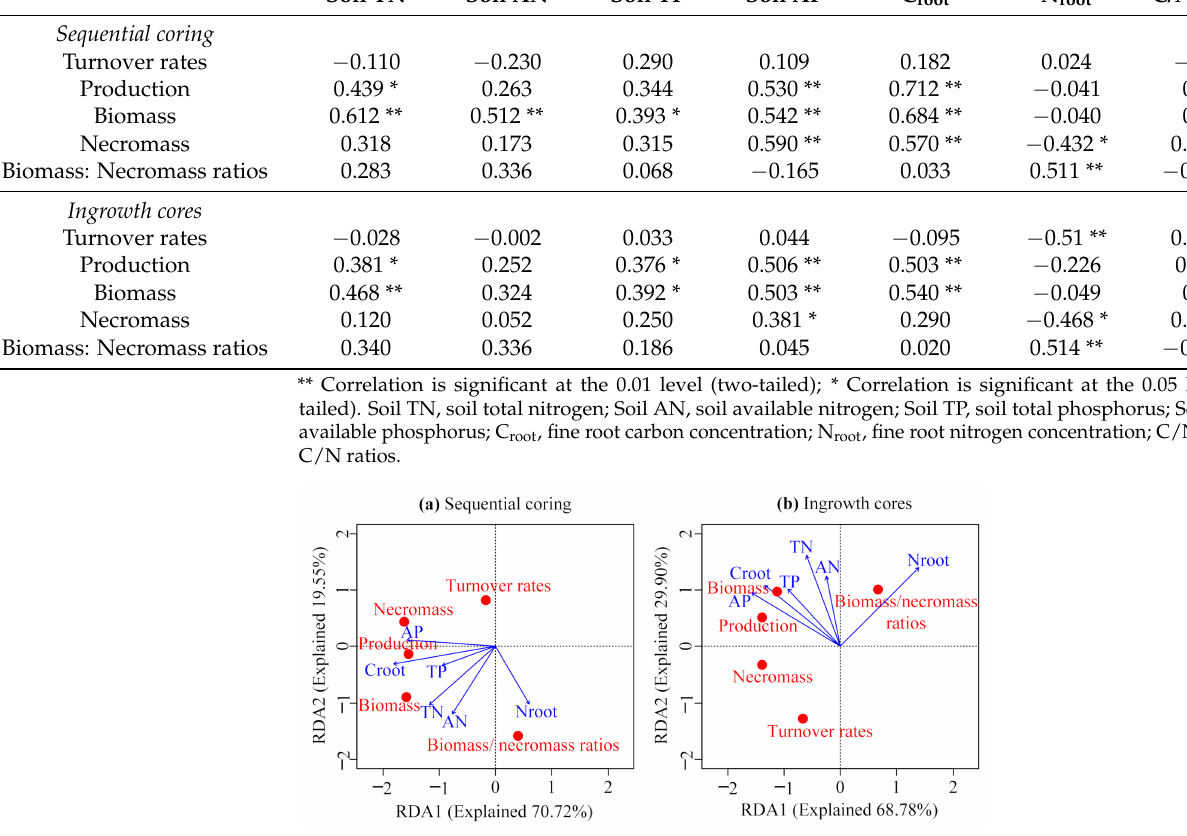
Figure 4. RDA results showed the effects of fine root and soil nutrients on fine root turnover parameters. TN, soil total nitrogen; TP, soil total phosphorus; AN, soil available nitrogen; AP, soil available phosphorus; C root , fine root carbon concentration; N root , fine root nitrogen concentration. Monte Carlo test of the RDA analysis (( a ). F = 5.14, p = 0.001; ( b ). F = 2.42, p = 0.011).